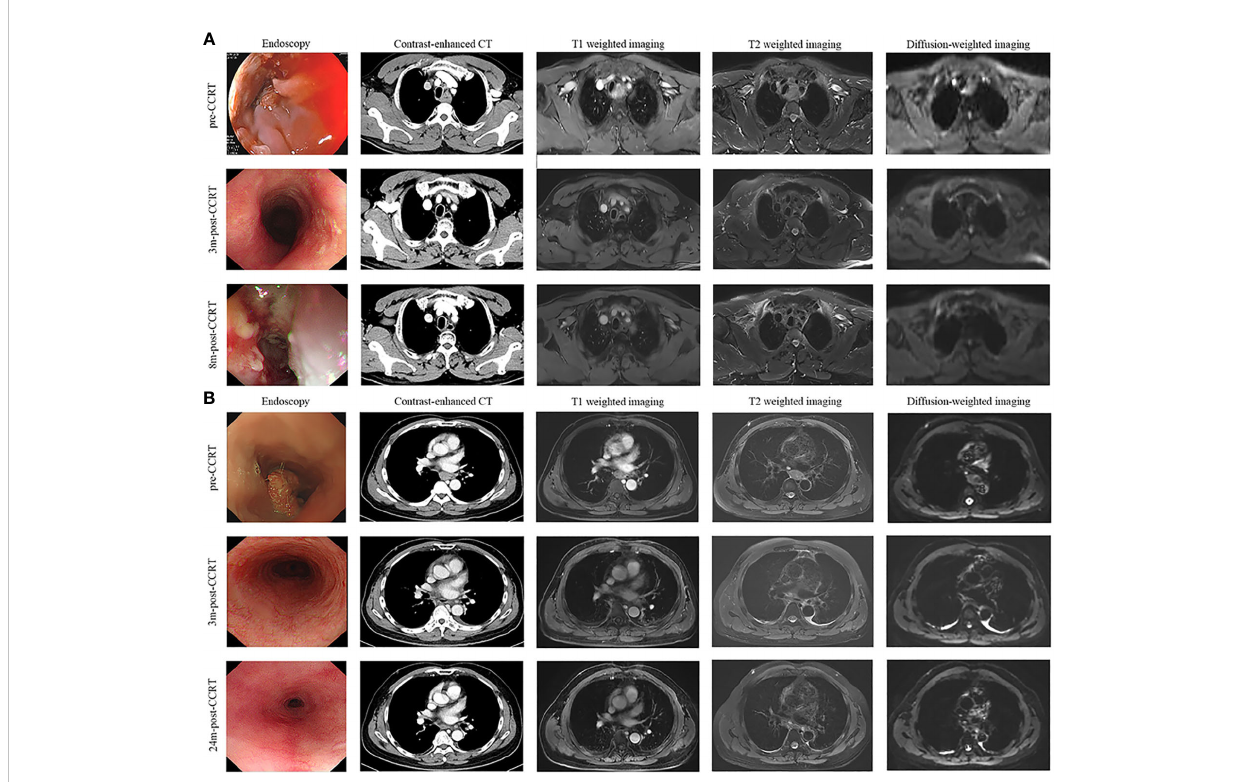
FIGURE 5 Disease evaluation by endoscopy, CT, T1-weighted, T2-weighted and diffusion-weighted sequences of MRI. (A) A 56-year-old, male patient was diagnosed with ESCC, which was located in the upper and middle thoracic esophagus. The treatment response of the case was assessed as CR after receiving CCRT. At 8 months after the completion of treatment, imaging examination showed no obvious abnormalities, but endoscopic examination revealed a small ulcerative lesion (red arrow) and pathological biopsy con fi rmed recurrence. (B) A 67-year-old, male patient was diagnosed with ESCC, which is located in the middle thoracic esophagus. The patient achieved CR after receiving CCRT and remained disease-free status in the 2-year follow-up period. ESCC , esophagus carcinoma; CCRT , concurrent chemoradiotherapy; CR , complete remission; 3m-post-CCRT , 3 months after CCRT; 8m-post-CCRT , 6 months after CCRT; 24m-post-CCRT , 24 months after